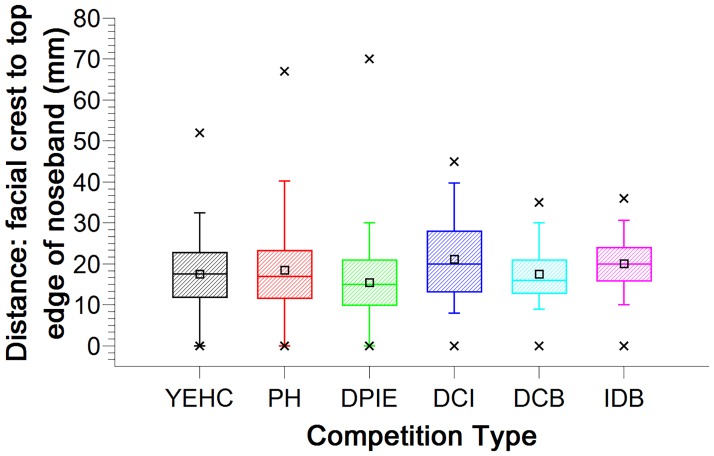
Boxplot and interquartile range of distance from rostral margin of facial crest to dorsal margin of noseband (mm) for six competition types.Maximum and minimum values are indicated by ‘x’, with whiskers identifying the 5% and 95% values. The large rectangles represent 25–75% of values, with the median value indicated by the thick crossline, and mean values by the small square symbol.